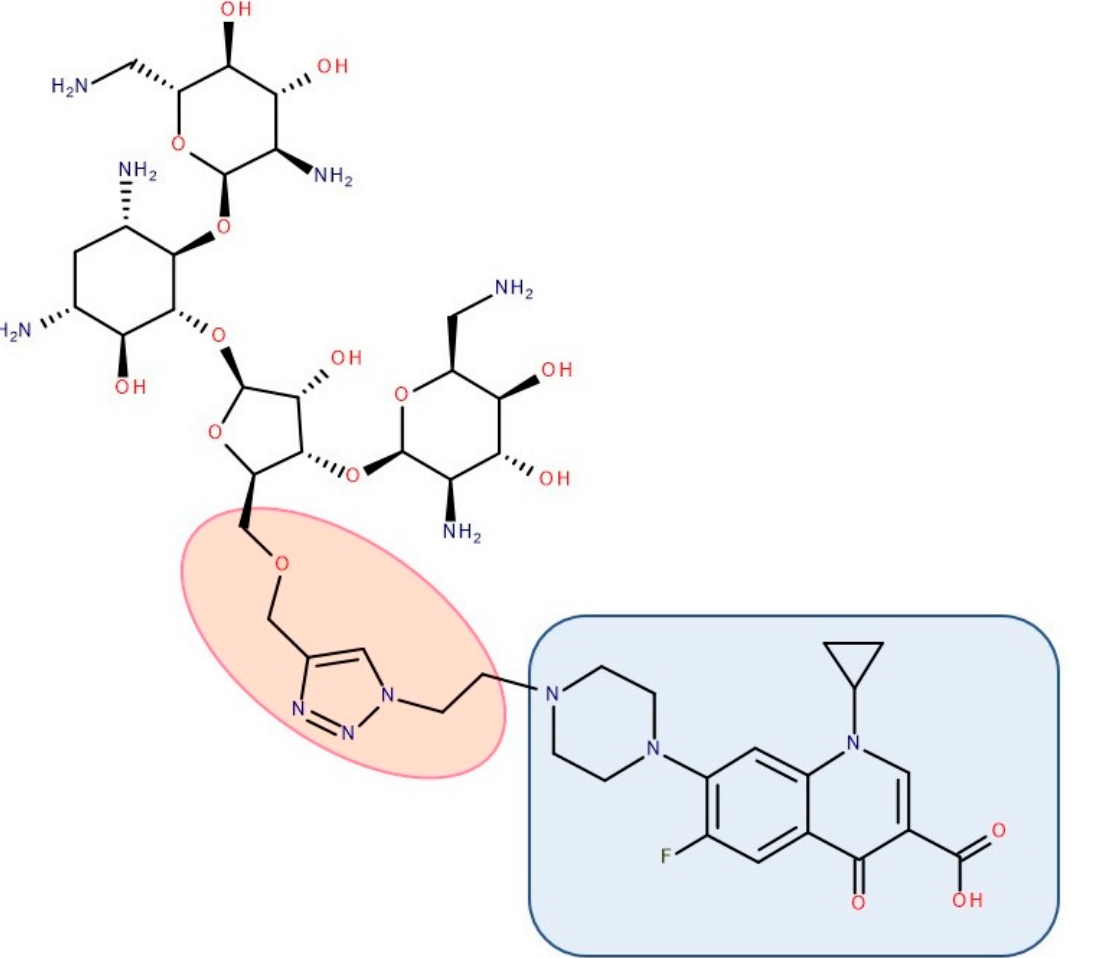
Figure 11. Antibiotic–antibiotic hybrid containing an FQN: neomycin B–linker–ciprofloxacin; the linker is highlighted with the orange circle while the QN/FQN unit is highlighted by the blue rectangle [216].